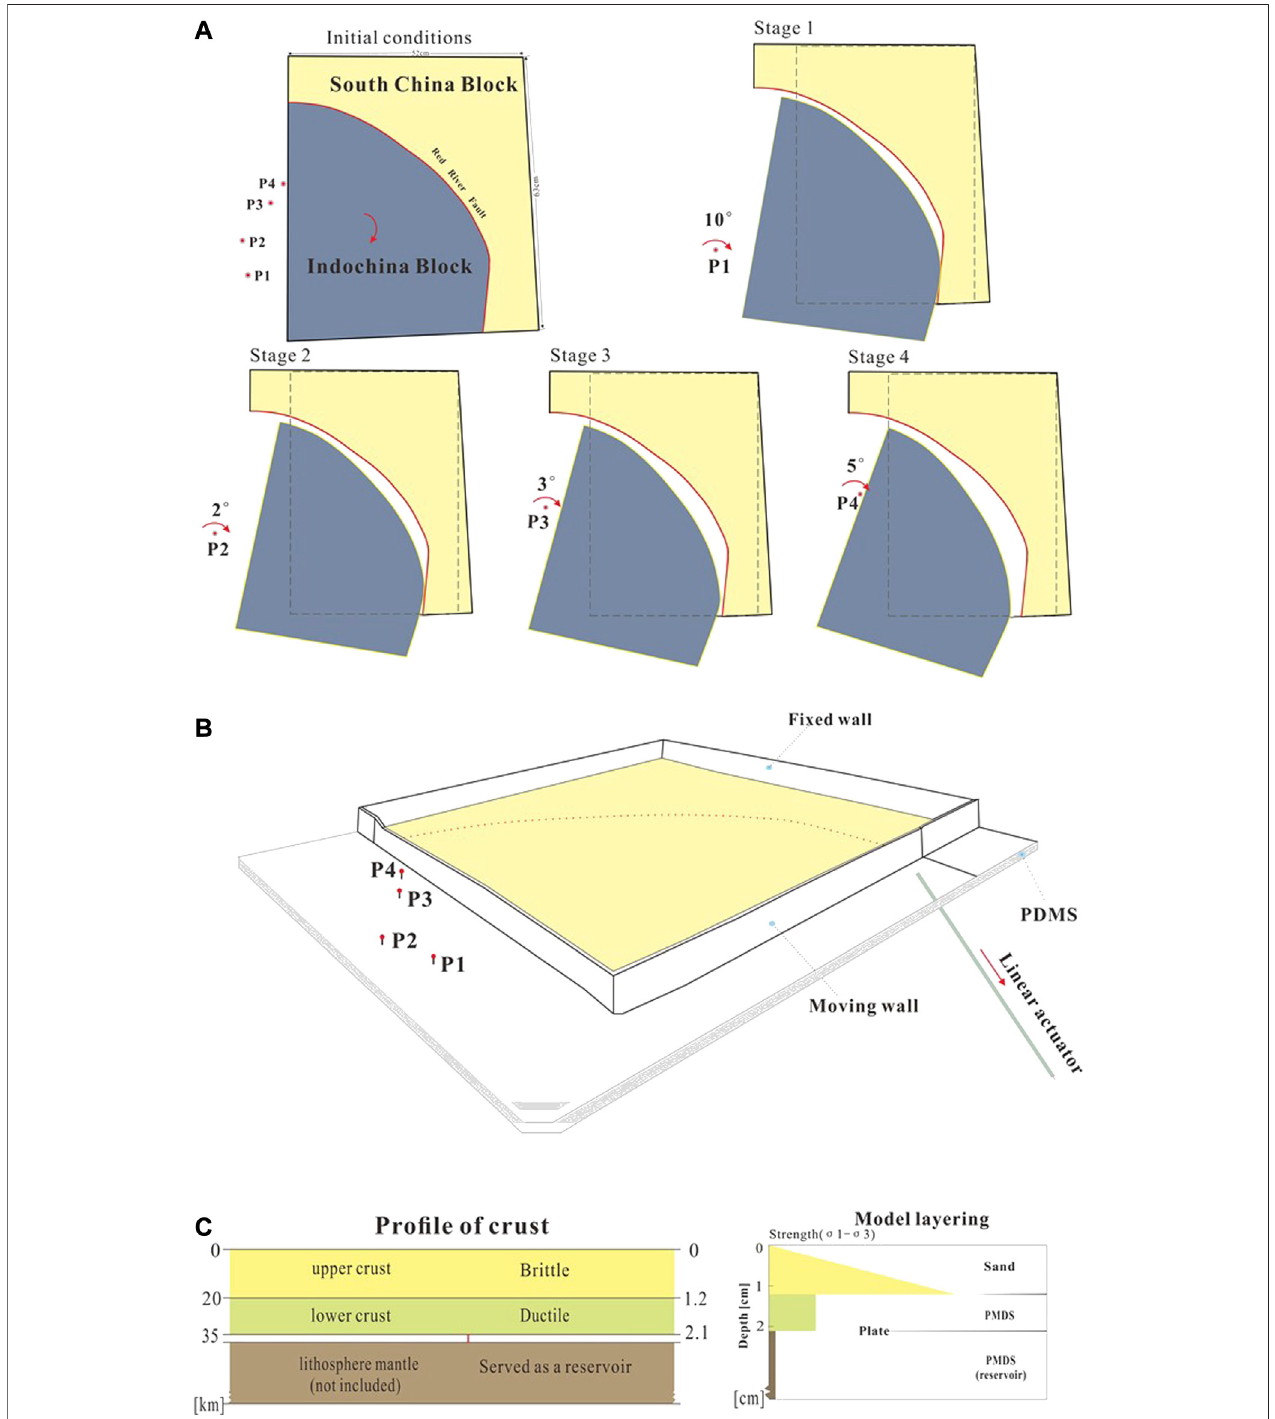
FIGURE 4 | Experimental setup: (A) graphical summary of the boundary conditions for the laboratory experiments presented in this article and plan view sketch of the rotational boundary condition, imposed by fi xing a pivot (P1, P2, P3, and P4) at one side of a moveable wall and pulling from the opposite side with a linear actuator; thedashedrectangleismonitoredbyacamera; (B) 3-Dsketchofhowthelaboratoryexperimentwasconstructed;and (C) pro fi leoftheanalogmodel(leftrepresentsthe thickness of the crust in nature, and right represents the scaled down thicknesses for our models) and representative strength pro fi les of the model lithospheres. Below the lower crust, there is a rigid plate, and the thickness of the plate is 2 mm.